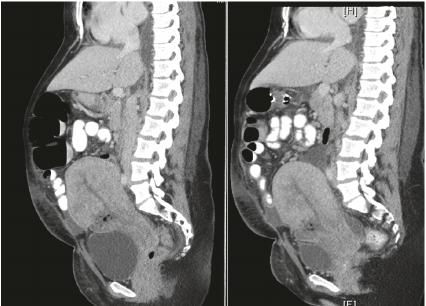
Figure 1: On the left, there is a CT A/P with IV contrast in sagittal view demonstrating that the uterus is enlarged and heterogeneously consistent and an approximately 2.6 x 2.5 cm defect is noted at the C-section incision site containing hypodense fluid and multiple bubbles of gas. Also, a focus of gas is also noted within the endometrial cavity. On the right, there is a CT A/P with IV contrast in sagittal view done two days after the one on the left demonstrating a persistent 2.6 cm defect at the C-section incision site containing fluid and multiple bubbles of gas. Now this defect is continuous with a 3.3 x 0.9 cm abscess along the anterior aspect of the